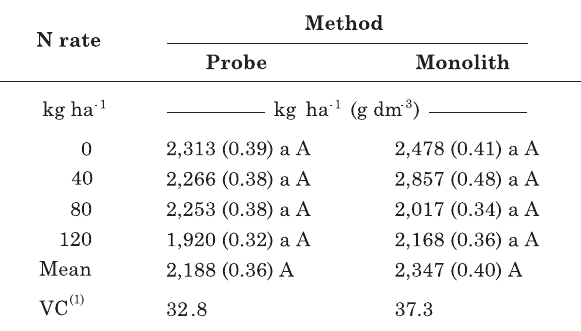
Table 2. Dry root mass of sugar cane down to a depth of 0.6 m at harvest (July/2006) as related to nitrogen fertilization at planting, by two evaluation